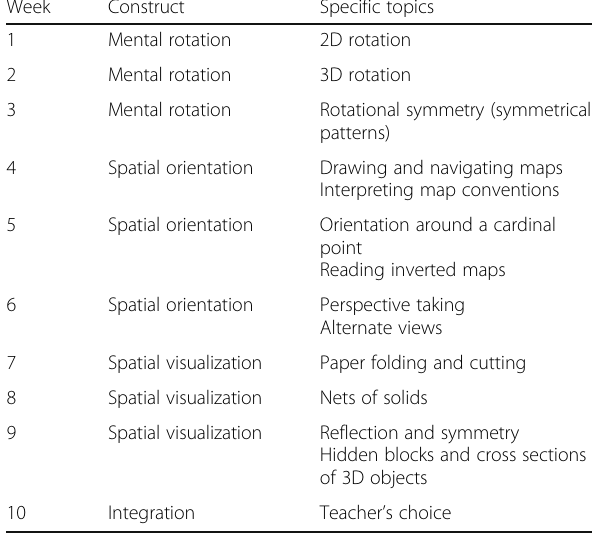
Table 2 Structure of the intervention